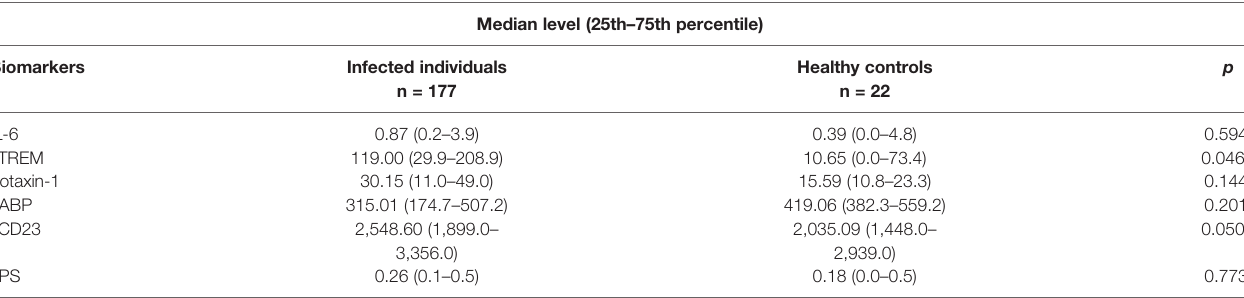
TABLE 2 | Comparison of median serum level of biomarkers between infected and uninfected